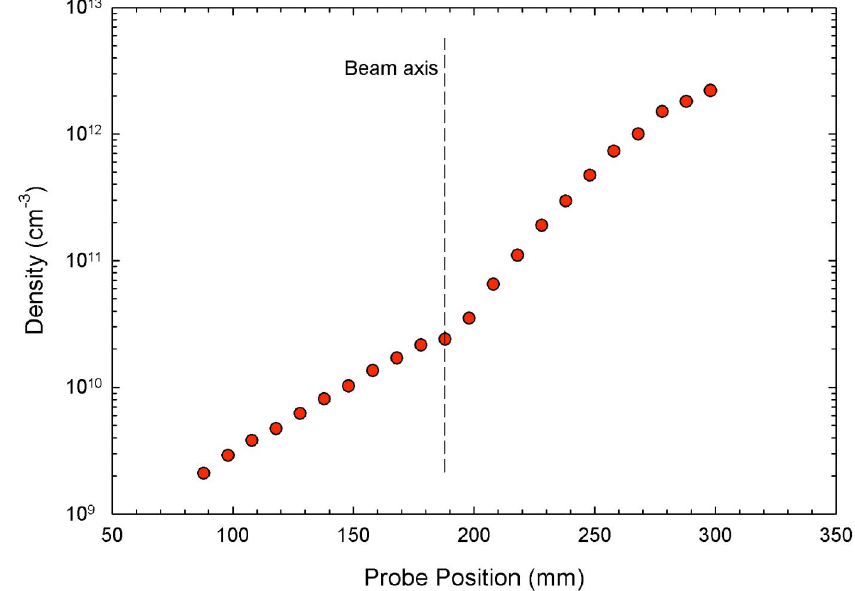
FIG. 33. (Color) Plasma density in the transverse direction, towards the rf power source, showing a steep gradient.